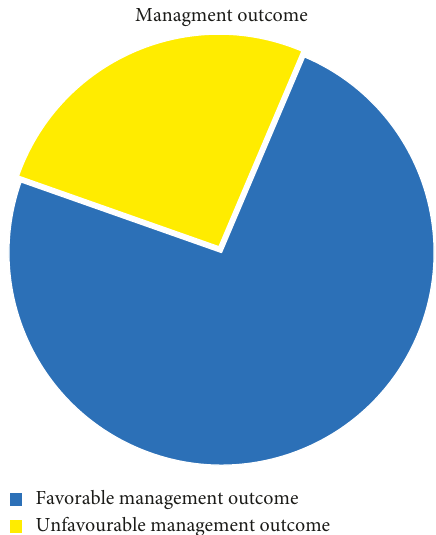
Figure 2: Management outcome of pediatric surgical patient’s admission to Arbaminch General Hospital, Southern Ethiopia,